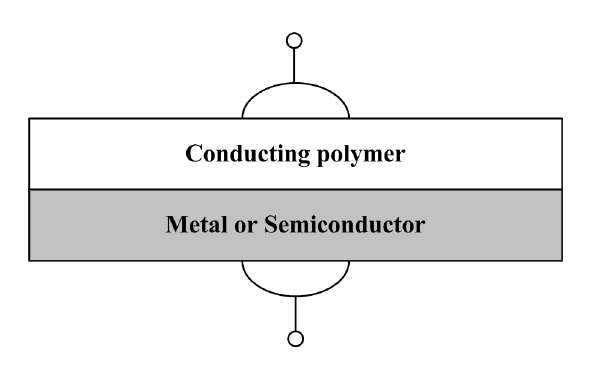
Figure 7. Configuration of diode